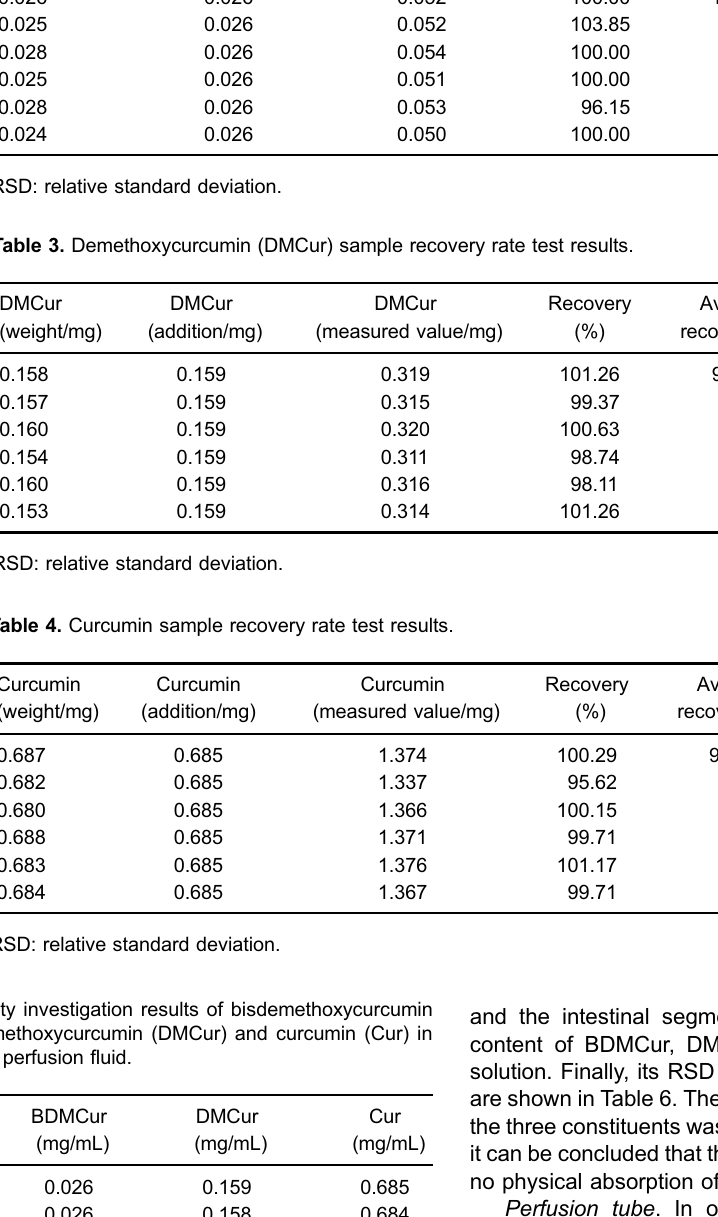
RSD: relative standard